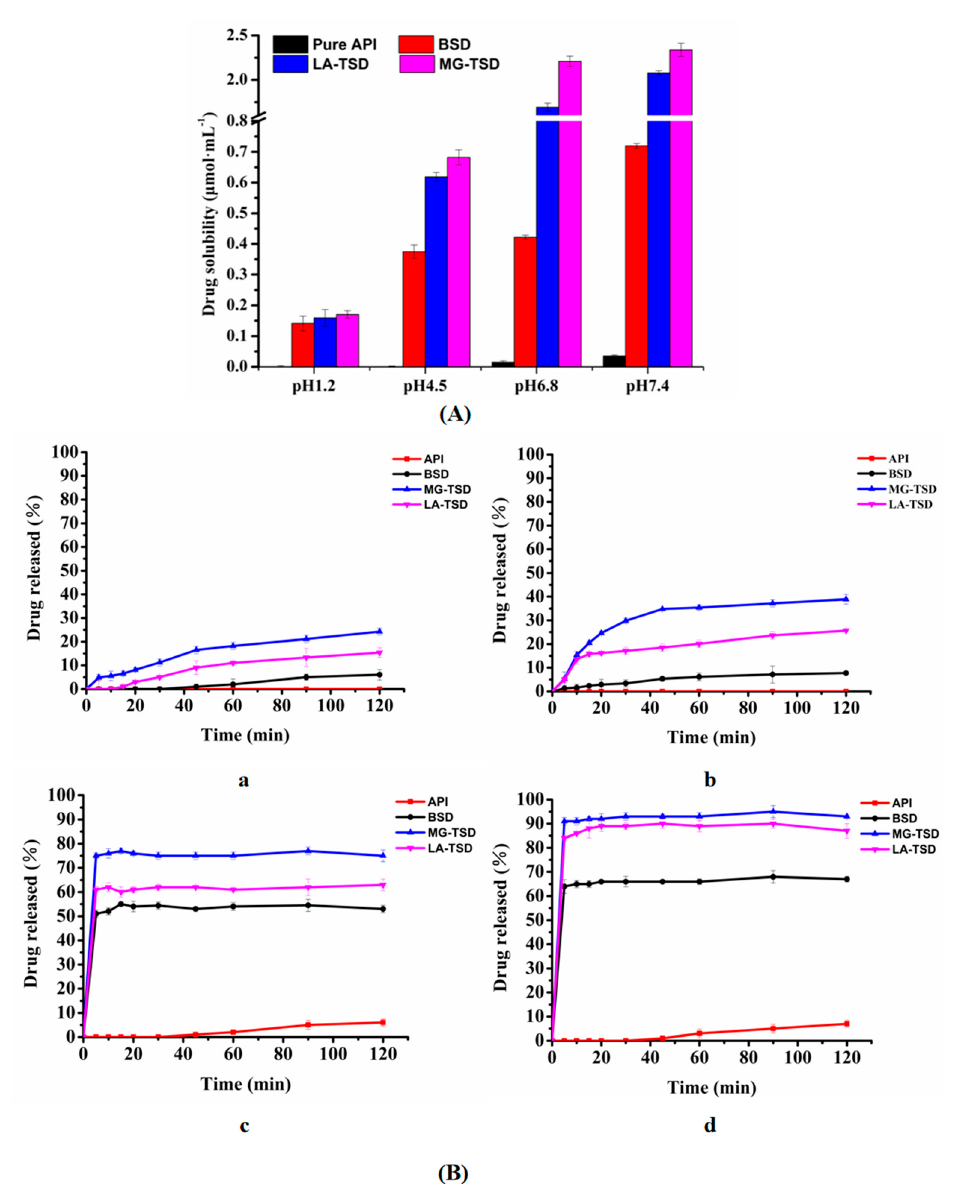
Figure 13. Solubility and dissolution of optimal formulations. ( A ) Solubility of GA, BSD, LA-TSD, and MG-TSD in HCl and different pH buffers ( n = 3). ( B ) Dissolution of GA, BSD, LA-TSD, and MG-TSD in ( a ) HCl (pH 1.2), ( b ) pH 4.5, ( c ) pH 6.8, and ( d ) pH 7.4 buffers ( n = 6).